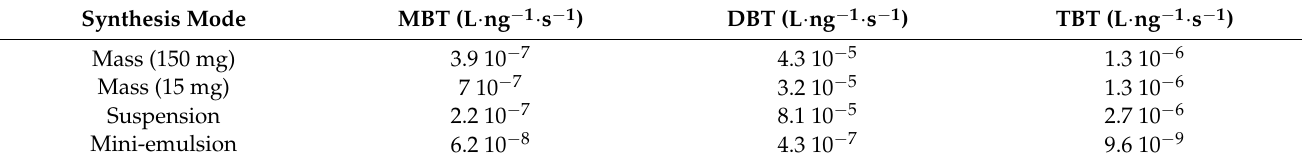
Table 3. Accumulation kinetic constants of OSn by MIPs synthetized in bulk, suspension, and mini-emulsion expressed in L · ng − 1 · s − 1